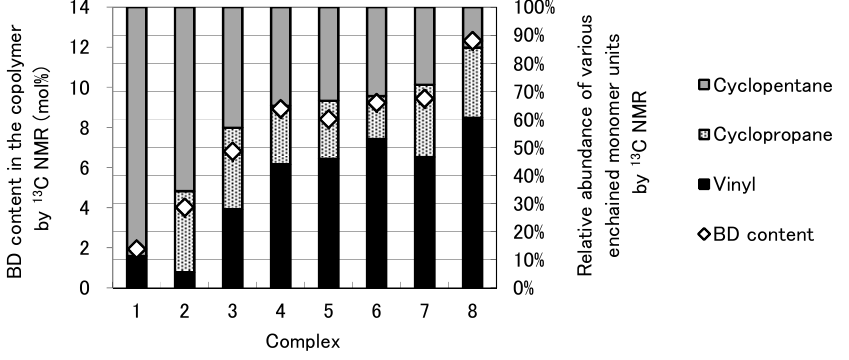
Figure 2. Butadiene content and relative abundance of various enchained monomer units (mol % calculated by 13 C-NMR) in ethylene/butadiene copolymerization by complexes 1 – 8 / i Bu 3 Al/Ph 3 CB(C 6 F 5 ) 4 . Polymerization conditions refer to entries 1 – 8 in Table